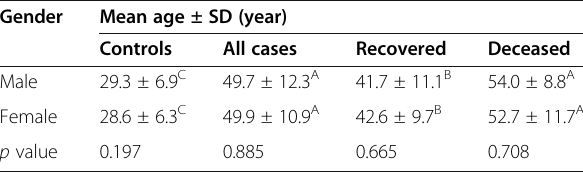
Table 1 Mean age of coronavirus disease 2019 cases and controls distributed according to gender